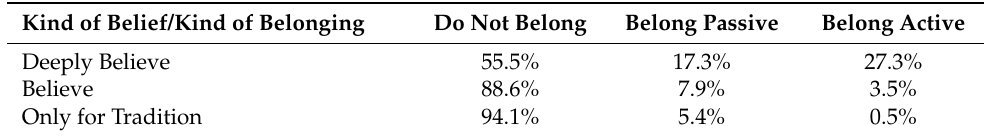
Table 4. Belonging to a religious association or